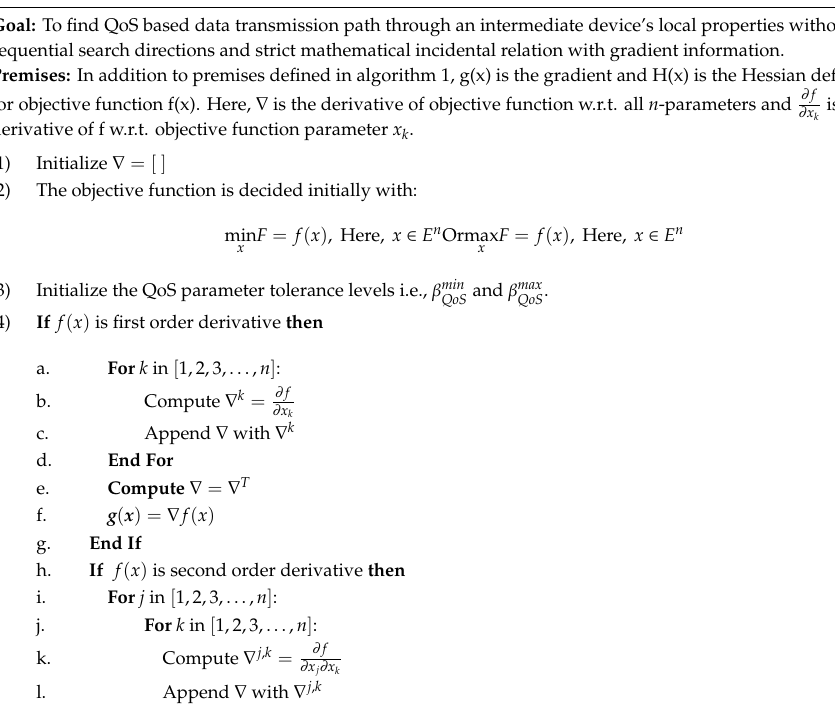
Algorithm 2: Proposed QoS-sequential Coordinate-descent Data Transmission Path Search Algorithm with Gradient